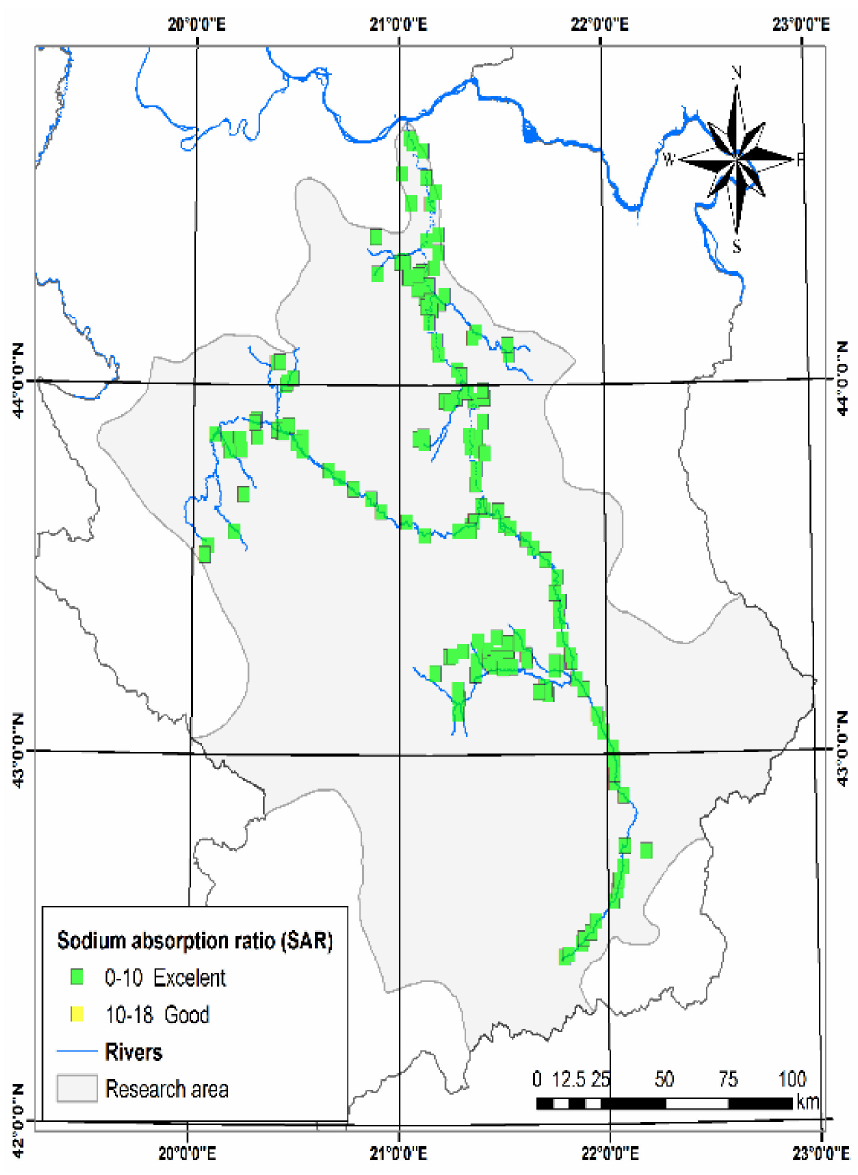
Figure 7. Spatial distribution of